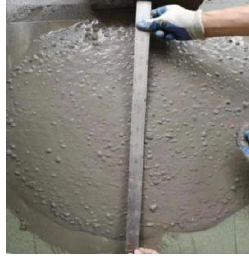
---- Table 2. Mix proportion of SCC. Raw Mate-